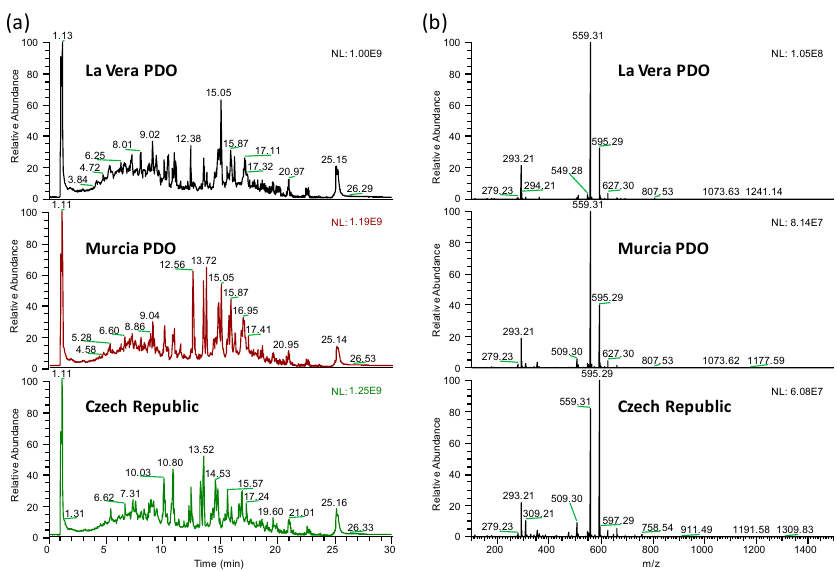
Figure 1. UHPLC-HRMS total ion chromatograms ( a ) and HRMS full scan spectra ( m/z 100–1.500) for the signal at retention time 15.05 min ( b ) of three selected sweet La Vera PDO, Murcia PDO, and Czech Republic paprika samples.